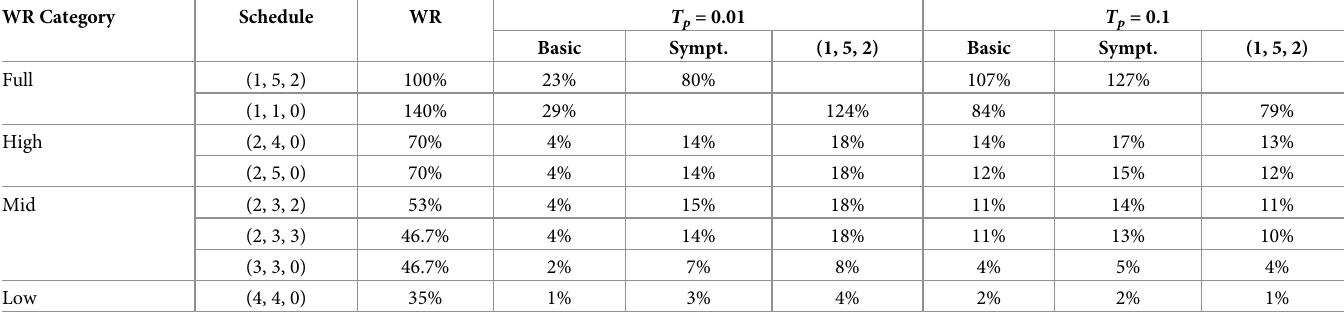
Table 3. Work and flattening ratios for various schedules against the basic, Symptomatic Quarantine, and (1, 5, 2) mechanisms for T p values of 0.01 and 0.1 in the contact graph model. WR Category